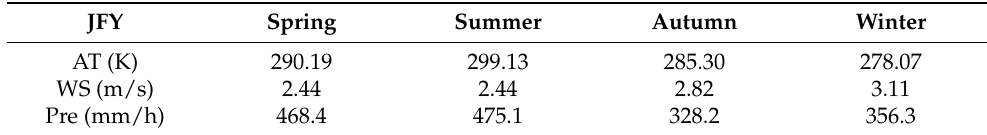
Table 2. Seasonal average measured data of air temperature (AT), wind speed (WS), and precipita- tion (Pre) at Hikone (observation point) for five years.